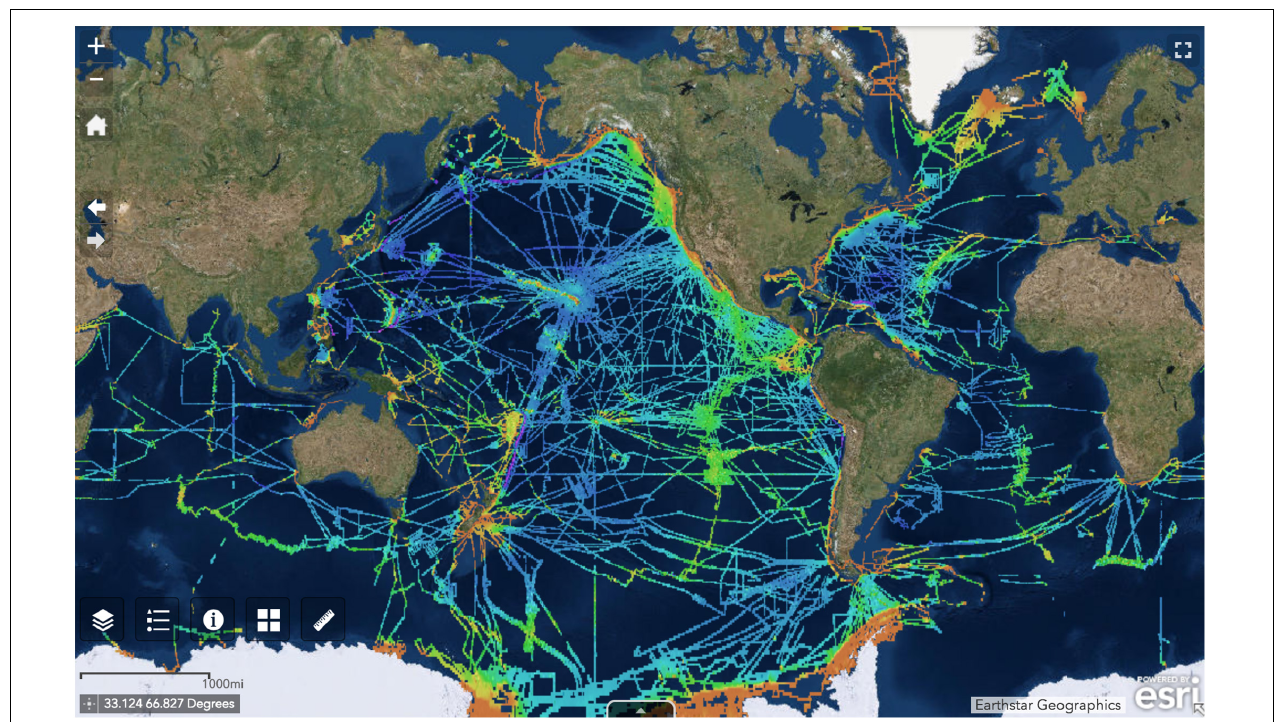
FIGURE 5 | Global extent of curated multibeam sonar data included in GMRT v3.6. Data have been reviewed, processed and gridded at 100 m. Combined with gridded data sets at a variety of resolutions and complemented by the GEBCO basemap, GMRT provides seamless access to global multi-resolutional bathymetric and elevation data.